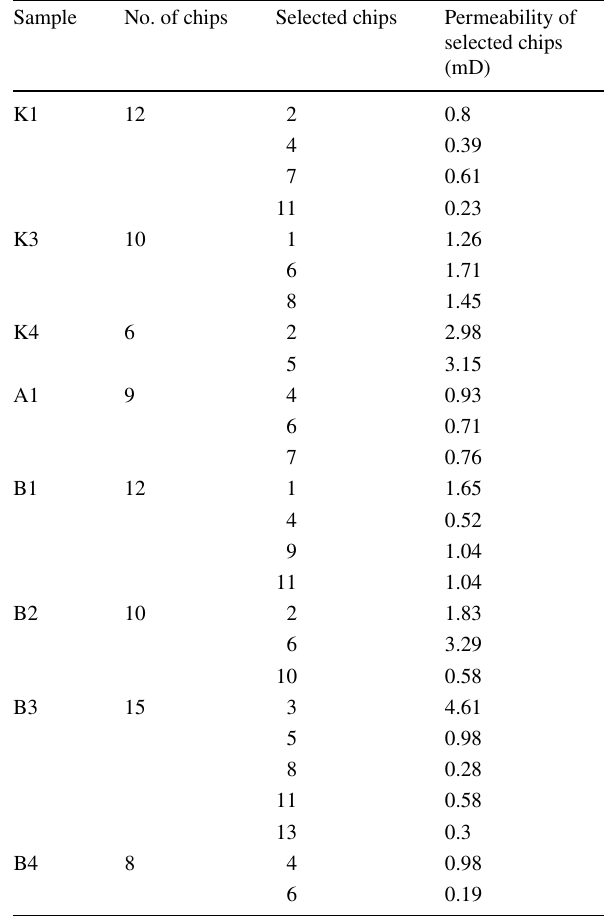
Table 4 Porosity of selected